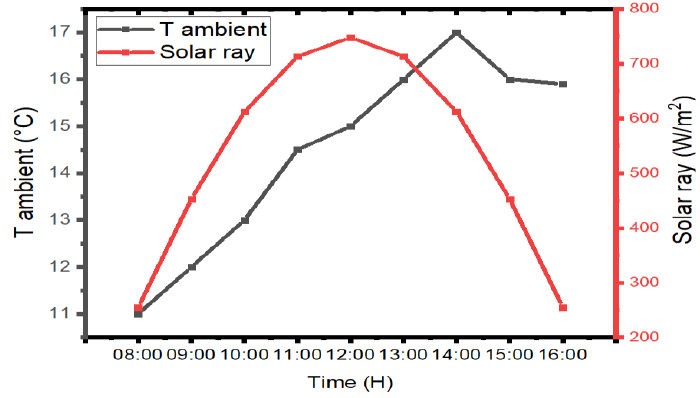
Figure 2. Evolution of solar radiation and ambient